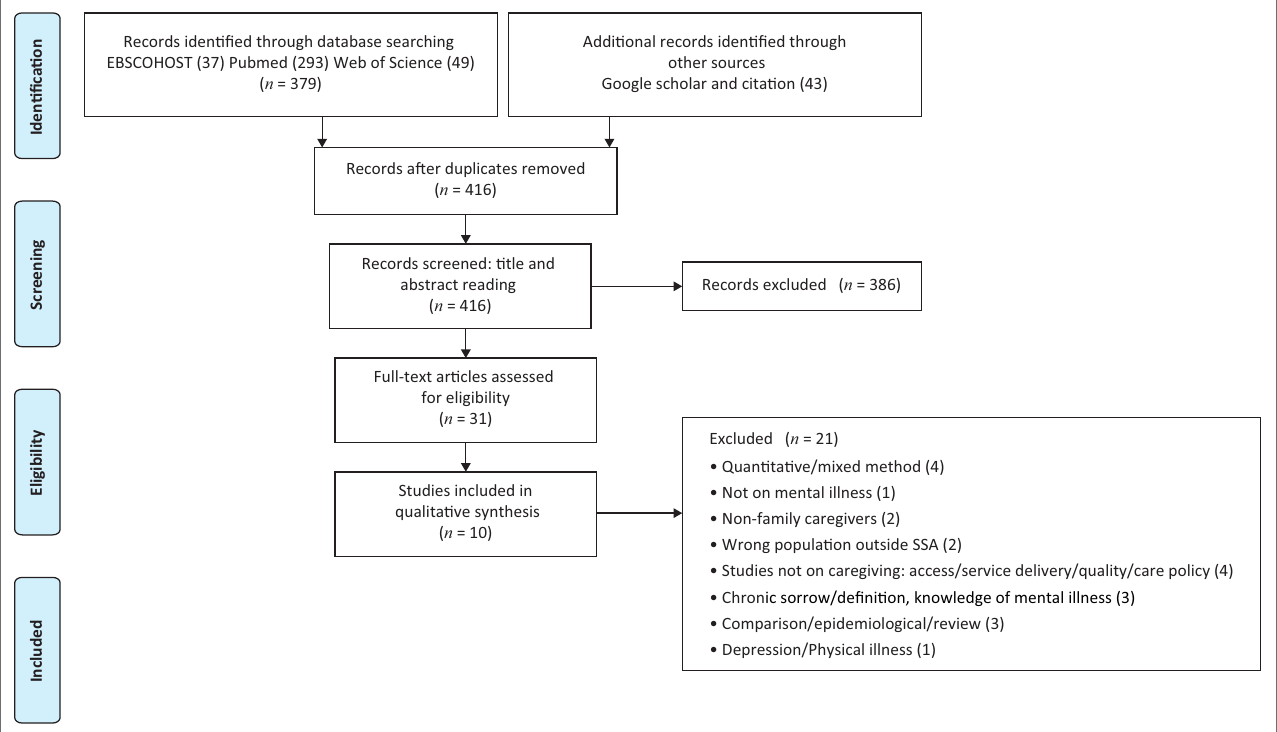
FIGURE 1: Prisma flowchart – study selection